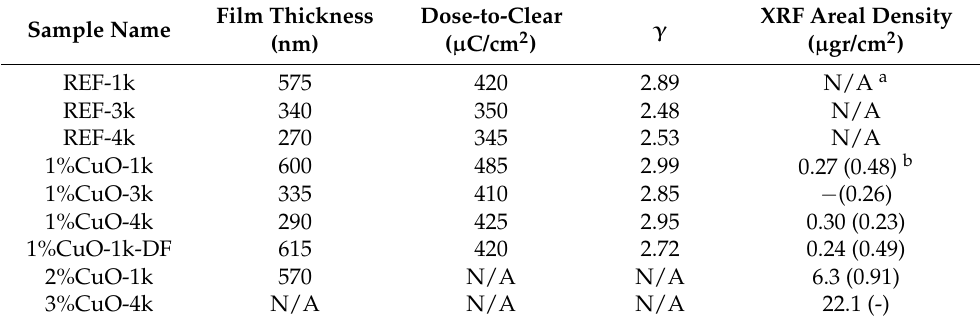
Table 3. Summary of Phase 1